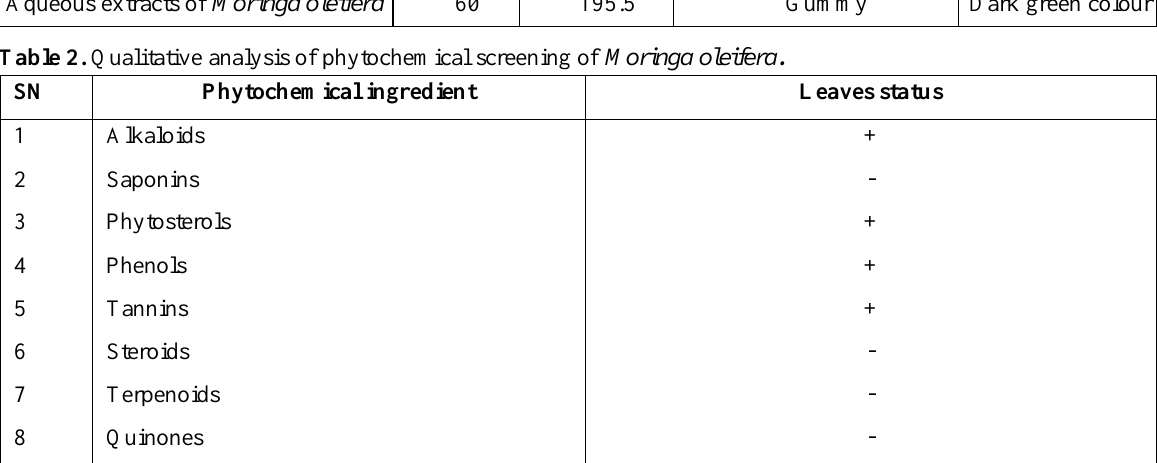
Table 2. Qualitative analysis of phytochemical screening of Moringa oleifera.